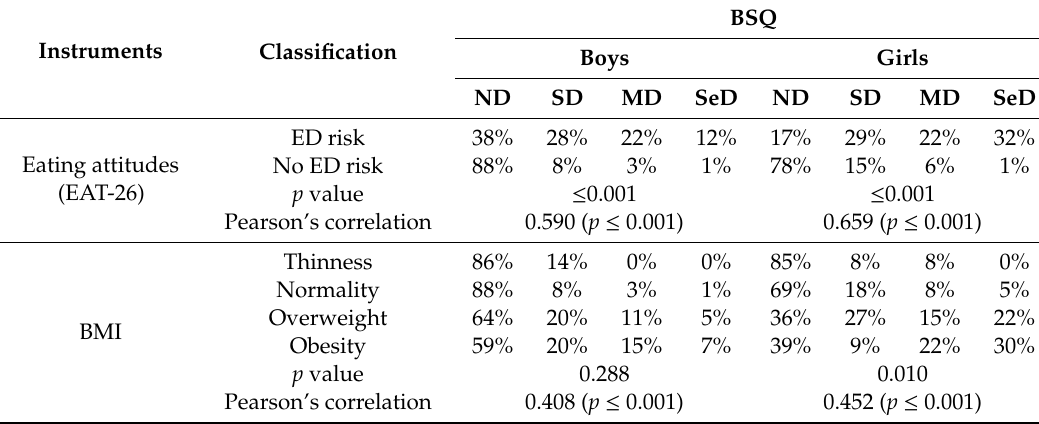
Table 5. Classification of adolescents by BMI and EAT-26 subscales, and their relation with BSQ.